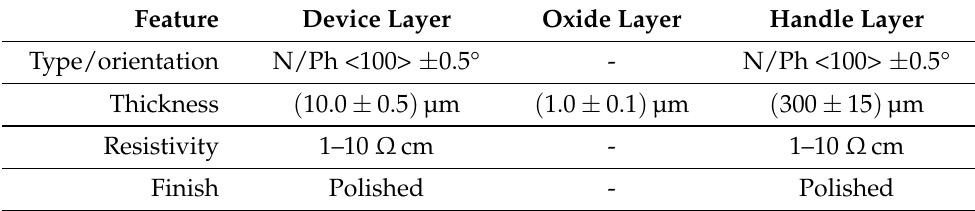
Table 3. SOI wafer specifications (Vendor: Si-Mat, Silicon Materials).